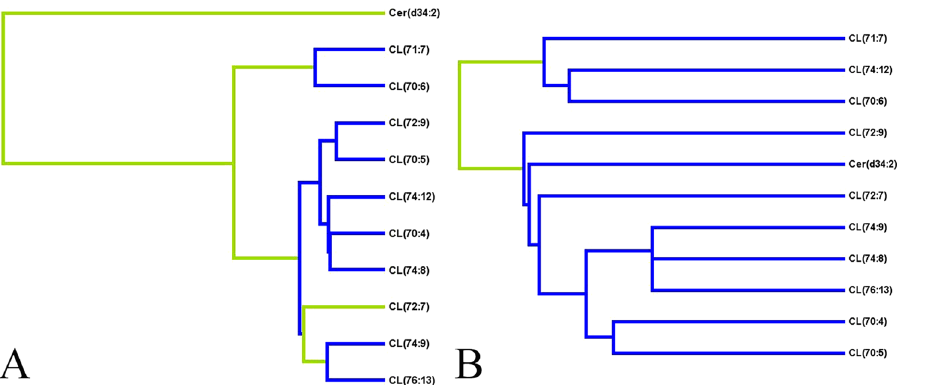
Figure 6. Potential biomarkers common to two LVTA models and their diagnostic potentials. ( A , B ) This figure gives HCA graph of 11 lipid species that were altered in both models, (A and B represent Models I and II,